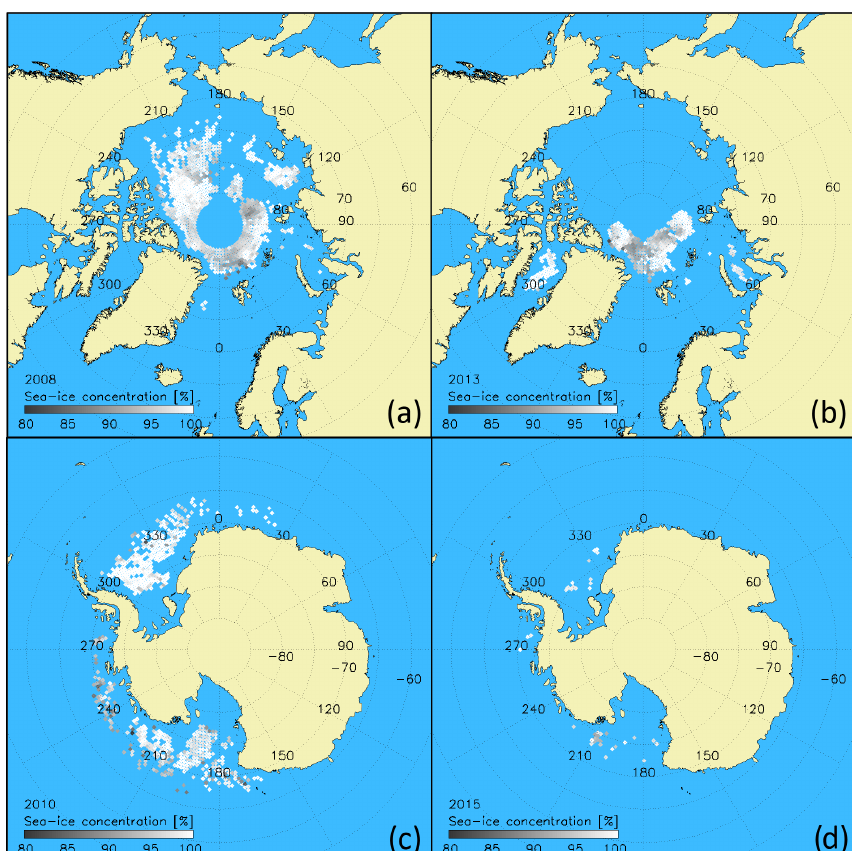
Figure 4. Illustration of the typical distribution of near-100% SIC reference data by means of the co-located OSI-450 sea-ice concentration for (a, b) the Arctic and (c, d) the Antarctic in a year with good (a, c) and poor (b, d) data